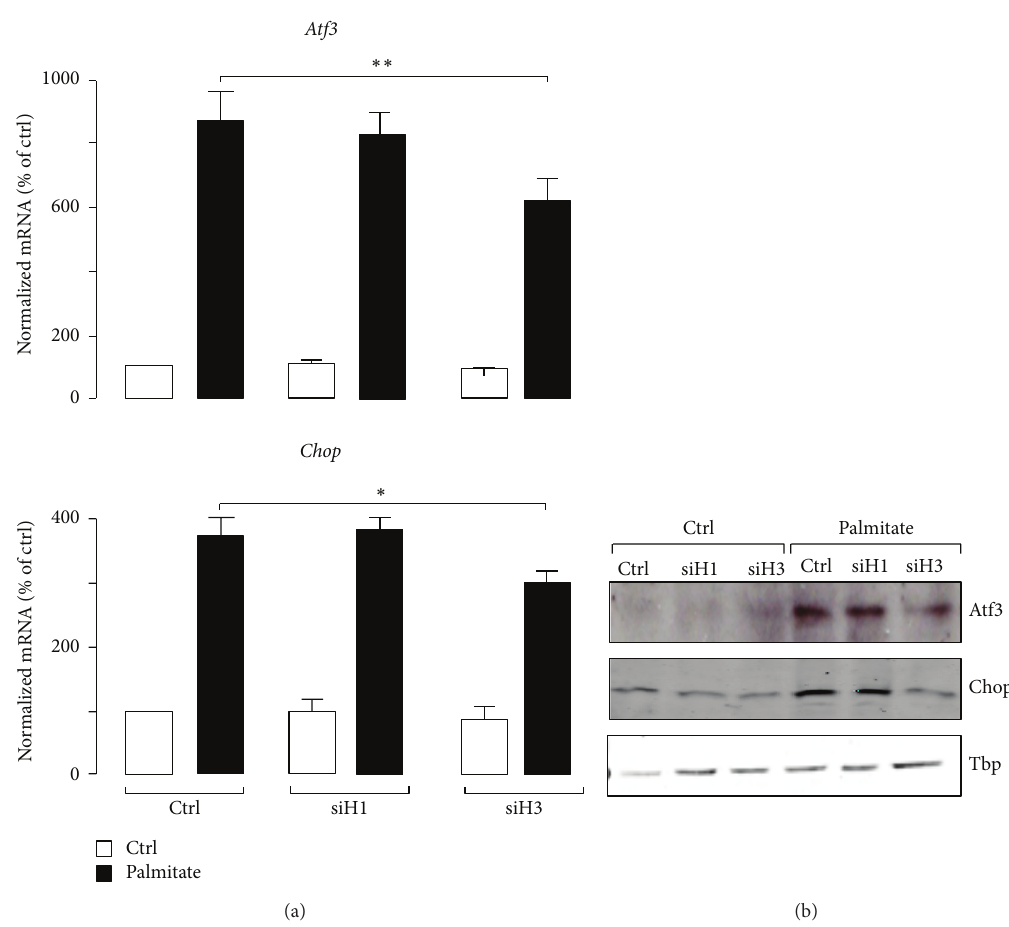
Figure4:EffectsofHDAC1andHDAC3silencingontheERstressmarkers.TheAtf3andChoplevelofMIN6cellstransfectedwithsiH1,siH3, or control siRNAs (siGFP) was quantified by (a) quantitative PCR and (b) western blotting experiments. Cells were cultured with palmitate ( filled bars ) or BSA ( open bars ) 24 hrs after transfection. Total RNA and nuclear protein extracts were prepared 48 hrs later. The mRNA levels were normalized against the Rplp0 and the expression levels from cells cultured with BSA ( − ) and transfected with siGFP were set to 100%. Data are the mean of ± SEM of 3 independent experiments ( ∗∗ 𝑃 < 0.01 ; ∗ 𝑃 < 0.05 ). For western blotting analysis, the anti-Atf3, anti-Chop, and anti-Tbp as the control were used. The figure shows the result of a representative experiment out of